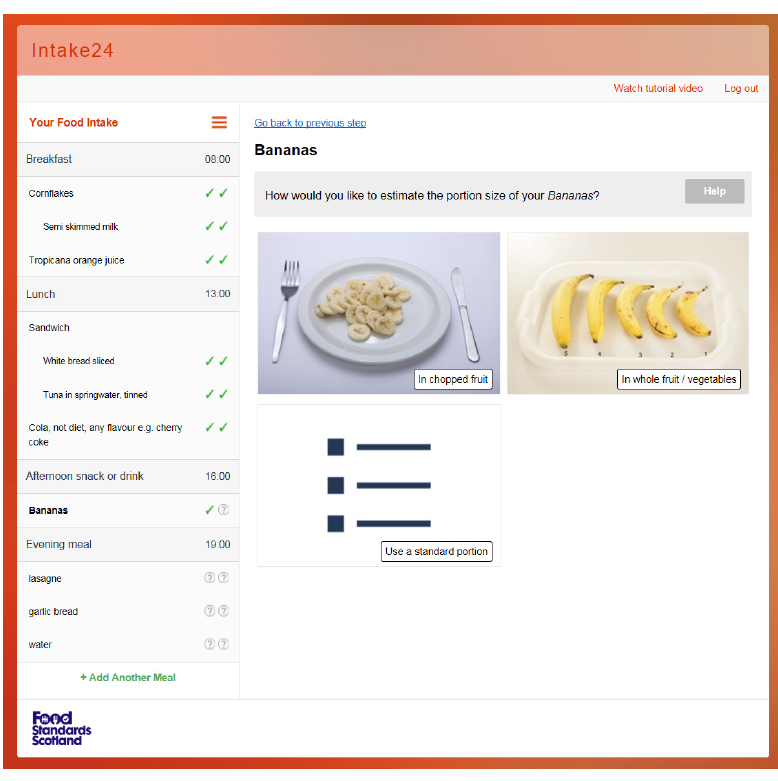
Figure 4. Portion size estimation in INTAKE24. Banana: chopped (as served), whole fruit (guide image), and standard portion.